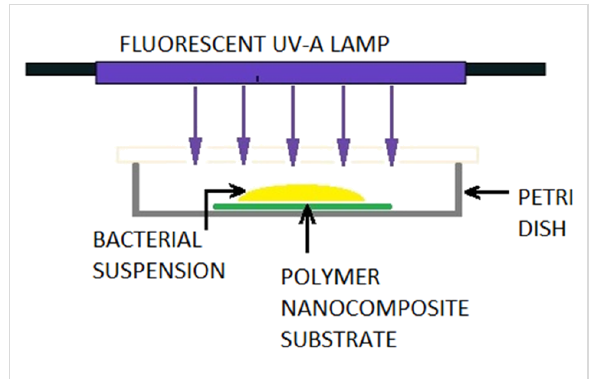
Figure 8: Schematic picture of setup for antibacterial experiments with TiO x